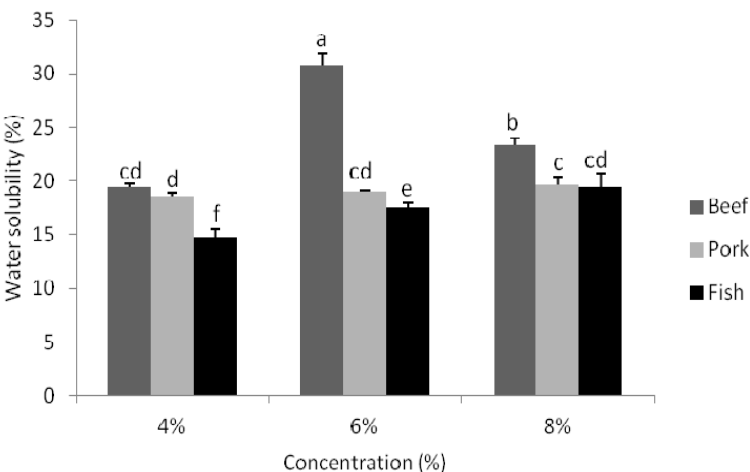
Figure 5. Water solubility values of composite films derived from beef, pork and fish gelatin sources with the concentrations of 4%, 6% and 8%. Error bars represent standard deviations of data with letters indicate significant differences ( p < 0.05) between the water solubility